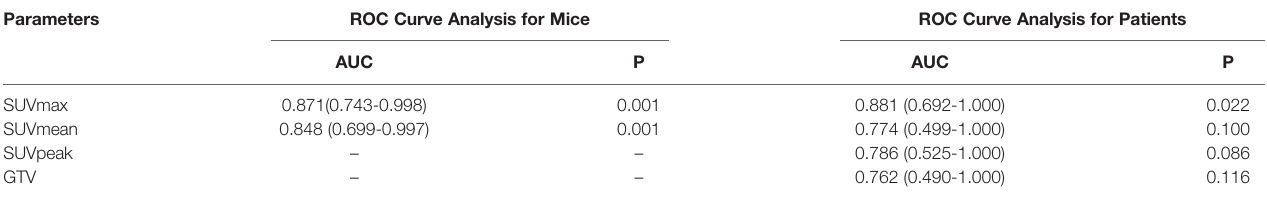
TABLE 5 | ROC curve of 18 F-RGD PET/CT parameters to predict tumoral PD-L1 expression status (relatively high/low) in tumor-bearing mice and patients. Parameters ROC Curve Analysis for Mice ROC Curve Analysis for